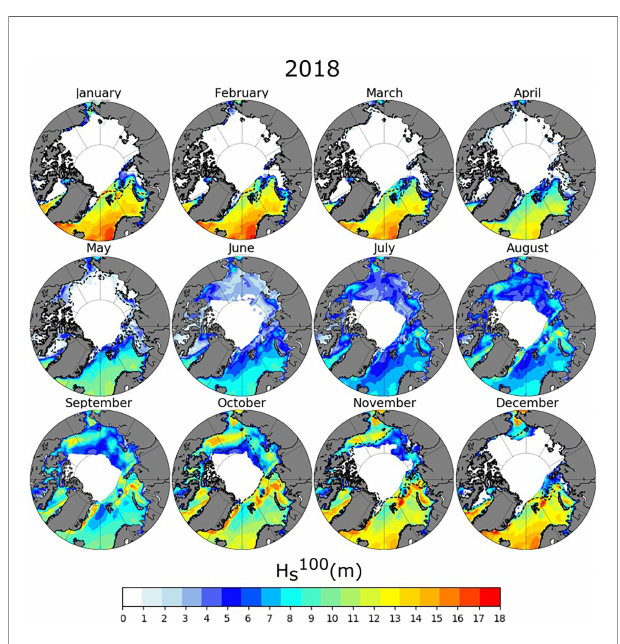
FIGURE 12 | H 100 s (m) for 2018 obtained with a POT analysis and a GPD distribution for the TS-EVA seasonal approach. Data obtained from the 28- year wave hindcast with ERA5 wind forcing. Dashed lines represent the minimum sea ice coverage in the period between 1991-1993 for each month.